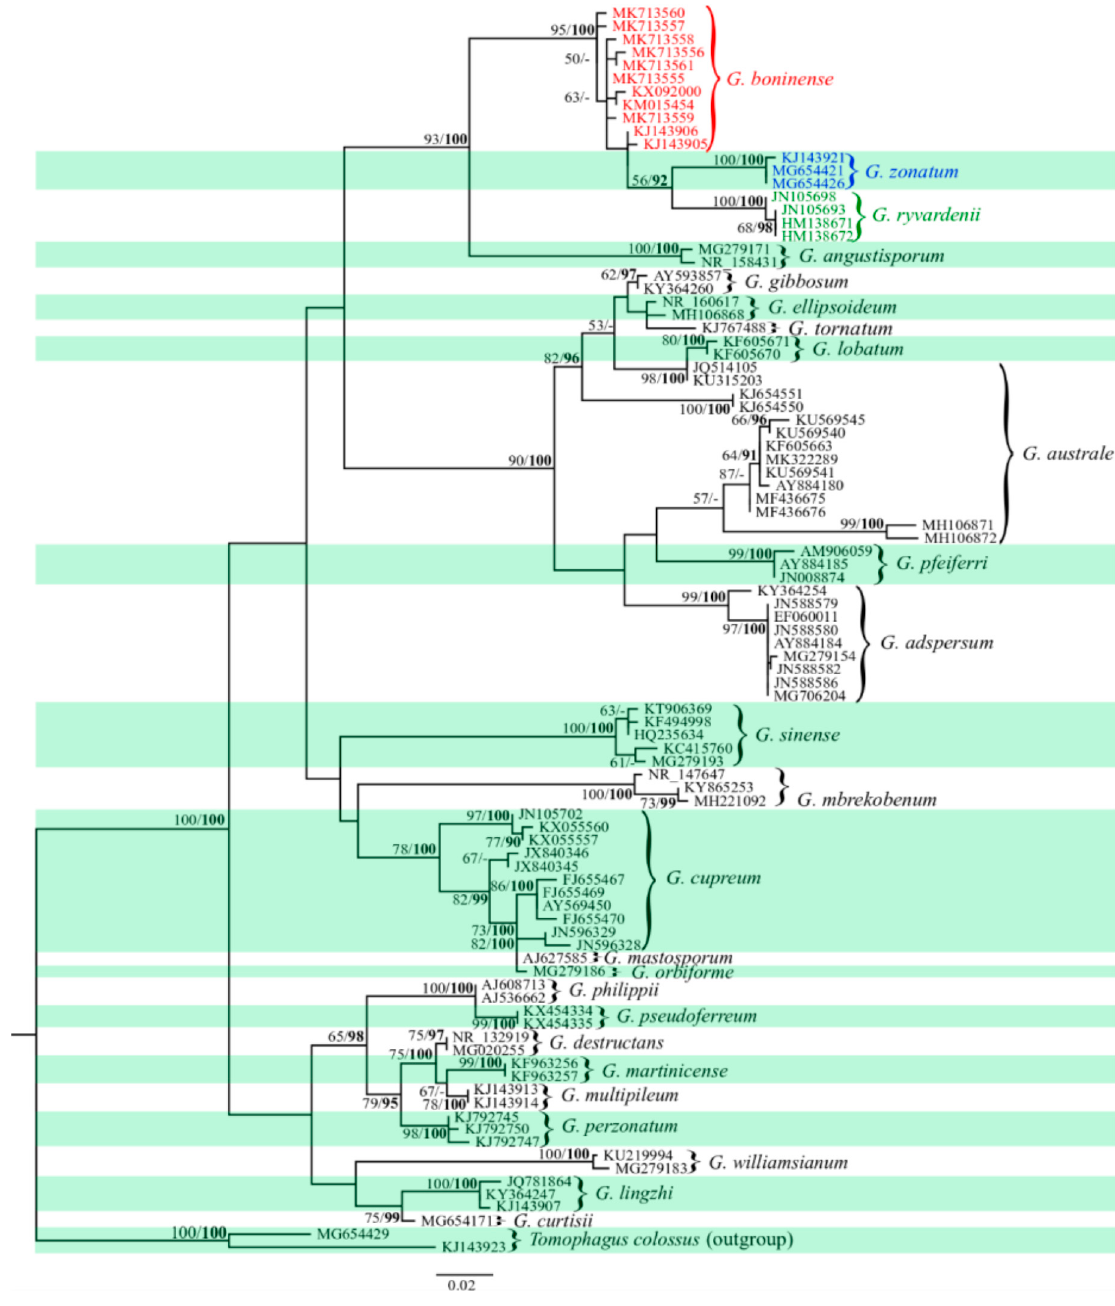
Figure 1. Phylogenetic tree constructed for G. boninense (species highlighted in red font) based on maximum likelihood (ML) and Bayesian phylogenetic analysis of internal transcribed spacers (ITS) sequences. Statistical values shown are ML-bootstrap values above 50% and Bayesian inference (BI) posterior probability above 90% (in bold). The scale bar (0.02) indicates the number of nucleotide substitution per site. Sub-clusters of G. ryvardenii and G. zonatum are highlighted in green and blue font, respectively. Tomophagus colossus is included as the outgroup. Data matrix and tree files can be viewed through the following URL: http://purl.org/phylo/treebase/phylows/study/TB2:S24430